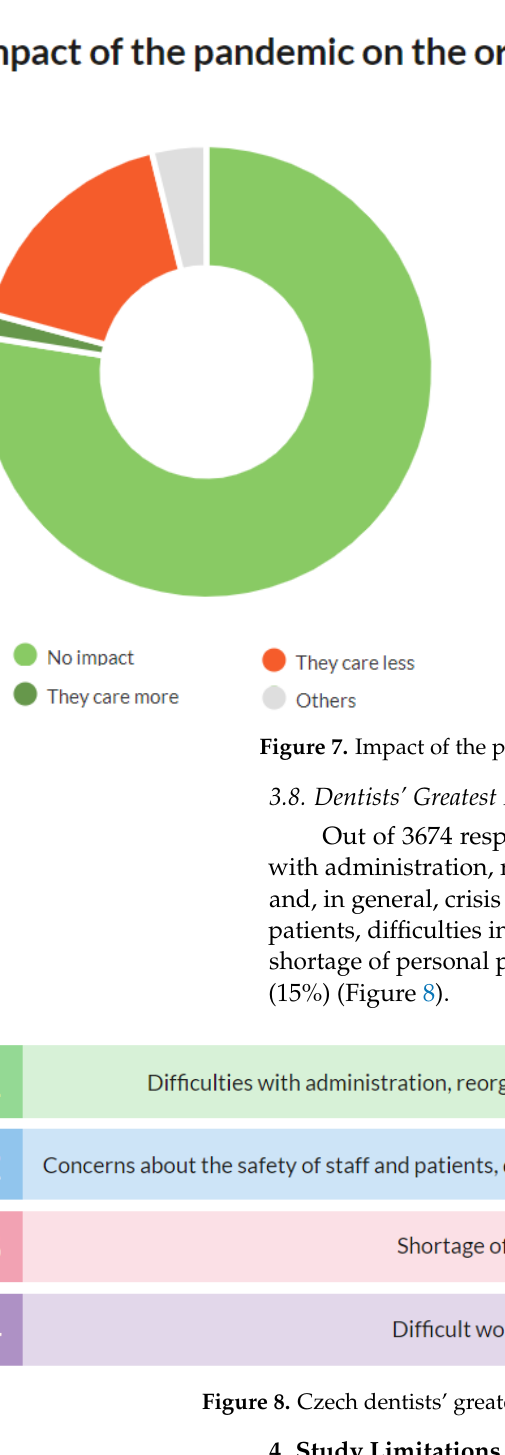
Figure 8. Czech dentists ’ greatest professional difficulties during the pandemic.